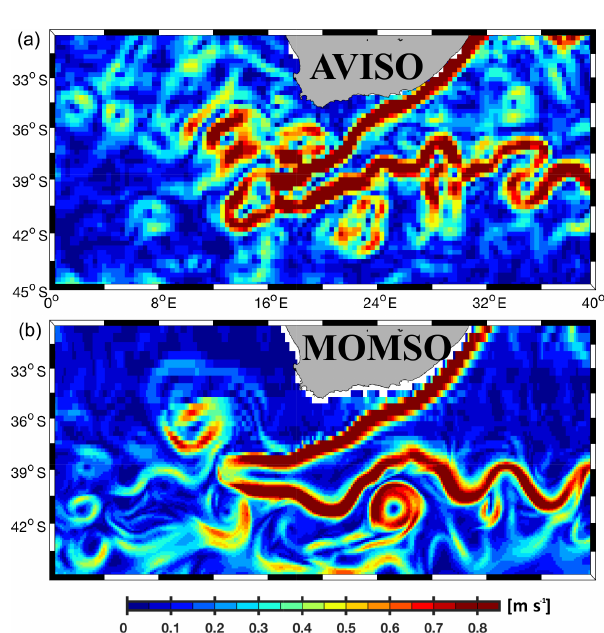
Figure 6. Magnitude of surface velocities. Panels (a) and (b) show typical snapshots as observed from space (Aviso, 3 May 1995) and as simulated (MOMSO, 3 May of nominal year 2020), respectively. This is a close-up from Fig. 5, focusing on those latitudes where the meridional resolution transitions from eddy permitting in the south to eddy prohibiting in the north.